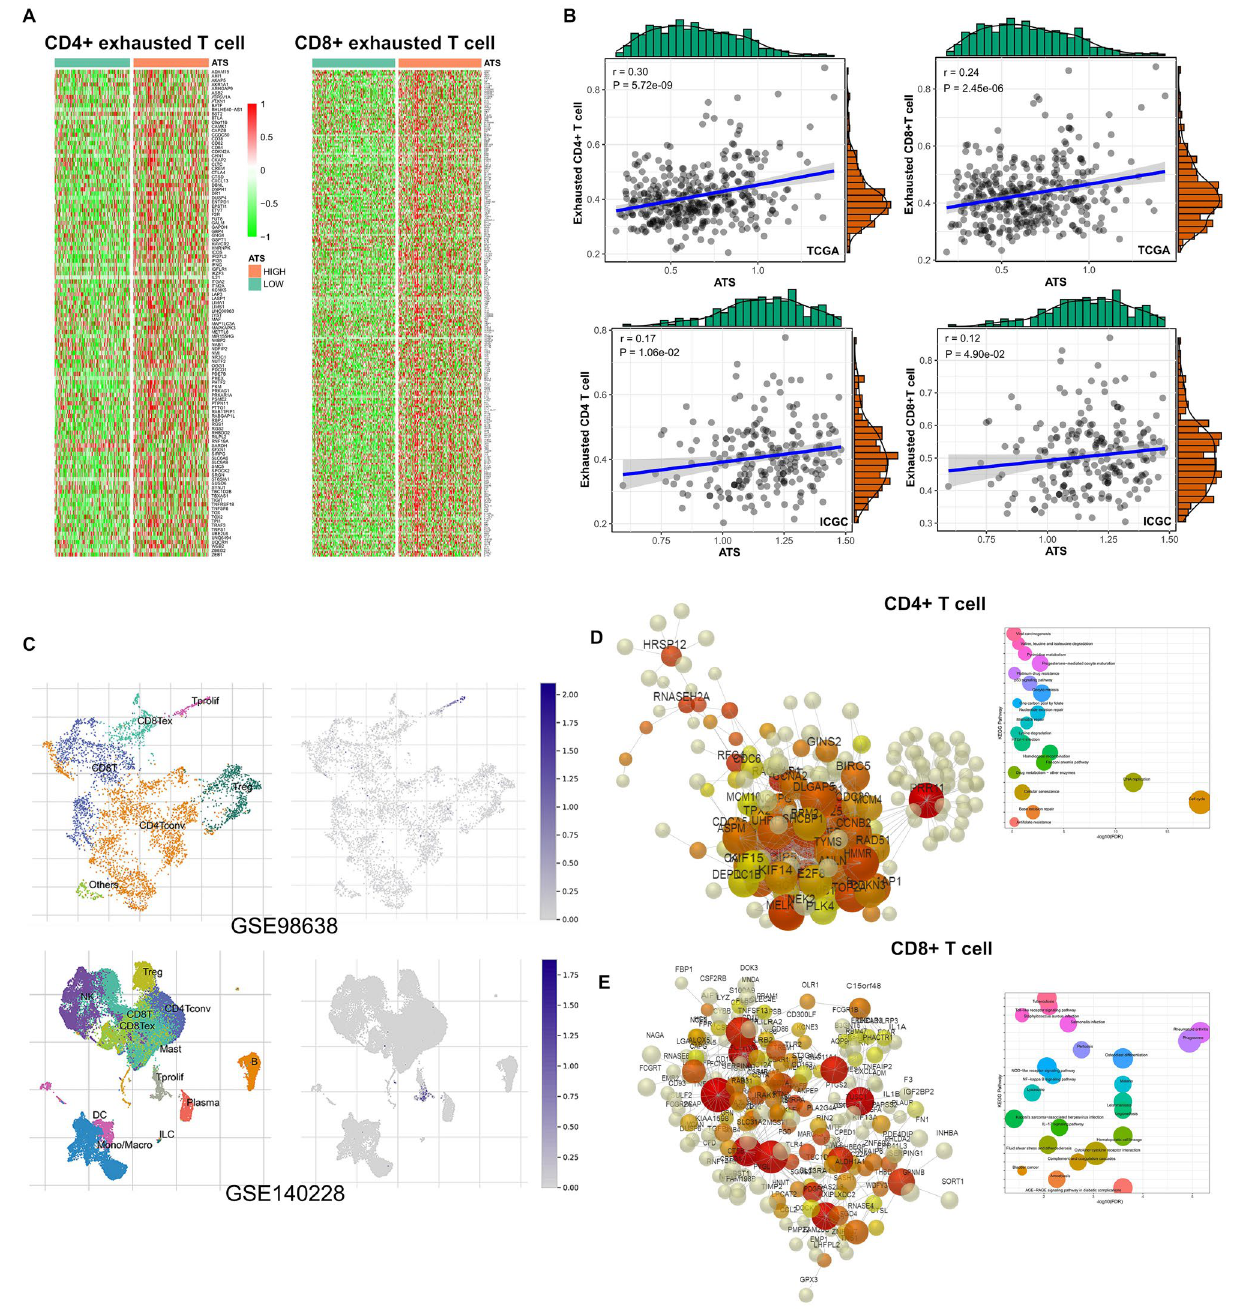
Figure 7. Impact of the ATS signature on T cells. ( A ) Marker gene distribution in exhausted CD4+ T cells and CD8+ T cells, respectively. ( B ) Correlation analysis of the ATS and the activity of exhausted CD4+ T cells or CD8+ T cells. ( C ) The distribution of ATS in different cell types using single-cell resolution. ( D , E ) ATS-related DEGs co-expression network and enrichment analysis in CD4+ and CD8+ T cells,